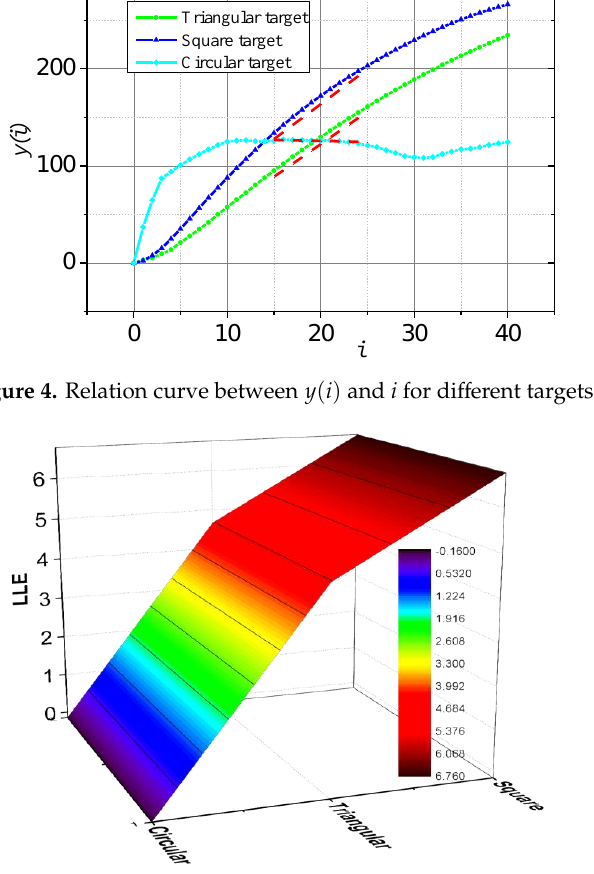
Figure 5. Largest Lyapunov exponent (LLE) of pressure signal time series in di ff erent flow fields.